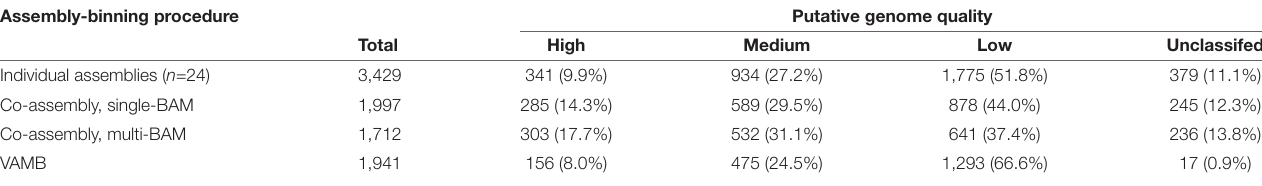
TABLE 1 | Number of MAGs (percentage of the total observed within workflow) from different assembly-binning workflows categorized by initial quality evaluation. Assembly-binning